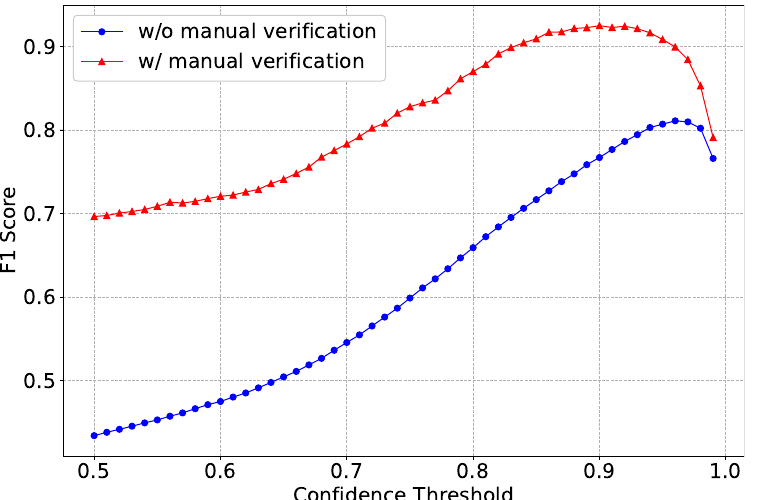
Figure 9. Variation of F1 score with confidence threshold for our workflow using Faster R-CNN + FPN on the validation set. The red and blue curves denote the results with (w/) and without (w/o) manual verification of detected craters,